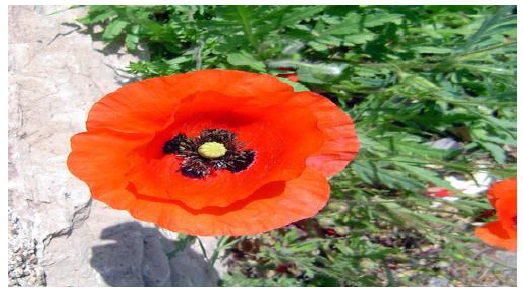
Figure 1. Iraqi Papaver rhoeas .